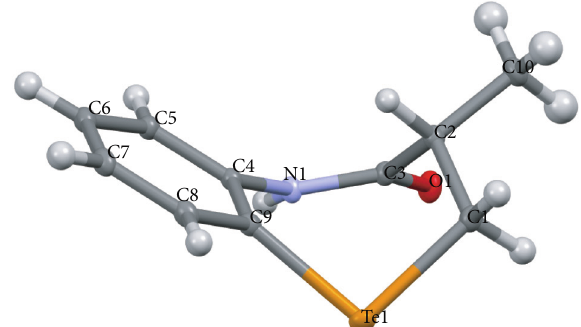
Figure 6: ORTEP plot of 3-methyl-2,3-dihydro-1,5-benzotellur- azepin-4(5H)-one 2